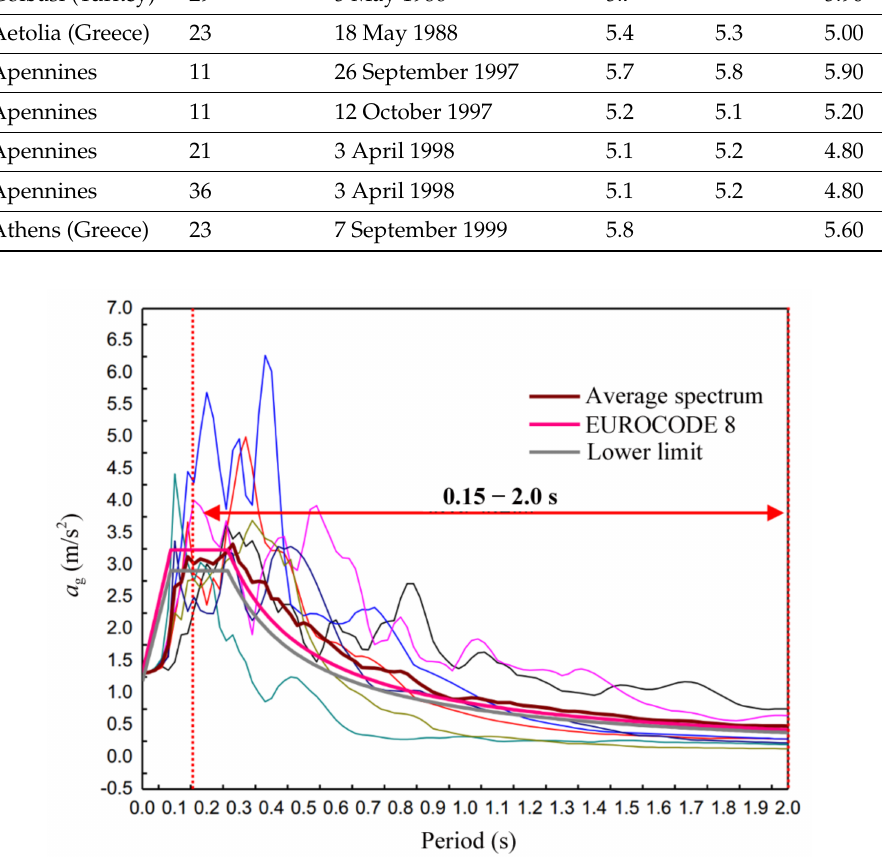
Figure 3. Response spectrum of the selected accelerograms and reference response